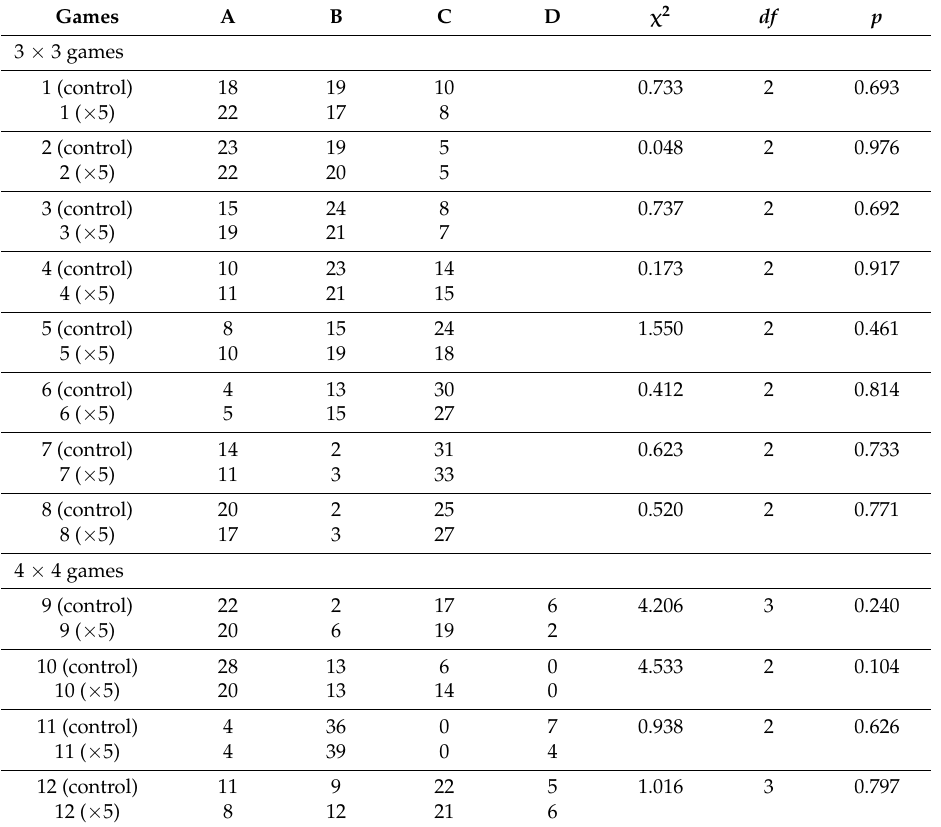
Table 3. Choices of players in the two treatment conditions (control and × 5 experimental) split by game number, with Chi square